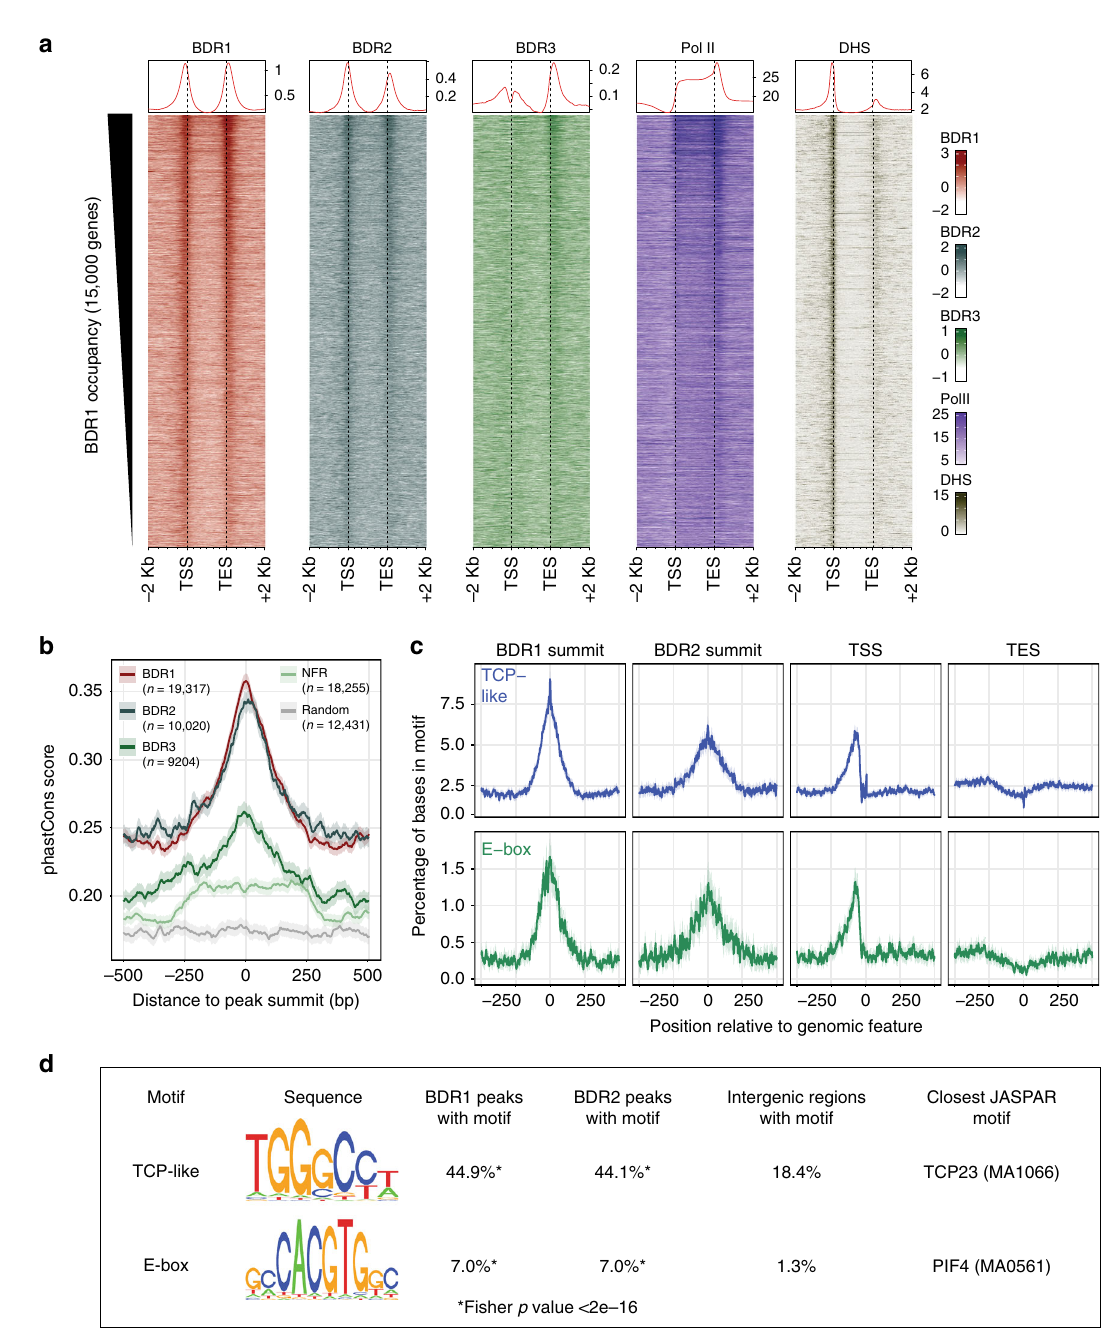
Fig. 3 BDR peaks contain evolutionarily conserved TCP-like and E-box motifs. a Heatmap and metagene pro fi les (top) of ChIP-seq signals and DNAse- hypersensitive sites (DHS). Genes were sorted by total BDR1 signal around the TSS and TES; the top 15,000 genes are shown. b Sequence conservation across 20 angiosperms for intergenic regions around BDR1, BDR2, and BDR3 peak summits, nucleosome-free regions (NFR), or random regions. Average phastCons score (line) and 95% con fi dence intervals (shade) are shown. c Enrichment of TCP-like and E-box motifs in BDR1 and BDR2 summits, TSS, and TES regions. d Motifs identi fi ed in BDR1 and BDR2